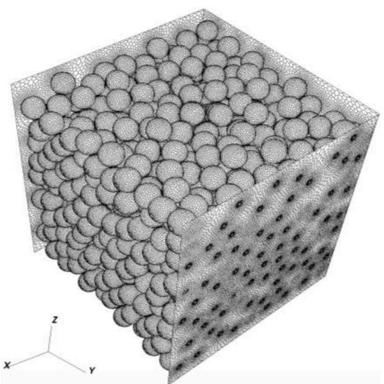
Surface mesh of pebble bed. Inlet (top), outlet (bottom), and x + side were removed for visibility.